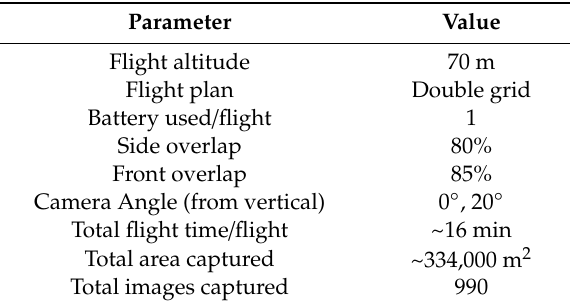
Table 1. Flight plan and image